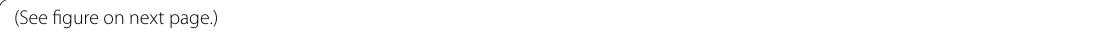
histopathology(See figure on next Fig. 7 Examples of false‑positive and false‑negative diagnosis of Meckel diverticulum. a A 4‑year‑old boy with false‑positive diagnosis of Meckel diverticulum which later proved to be Henoch–Schonlein purpura. Transverse ultrasound at the level of the gall bladder showed a lesion mimicking the pseudogestational sac sign. Nuclear study done after 4 days was negative. Clinical and follow‑up assessment confirmed the diagnosis of Henoch–Schonlein purpura. b A 2‑year‑old girl with false‑positive diagnosis of Meckel diverticulum and later diagnosed to be duplication cyst. Nuclear study done on the following day was negative. Retrospective analysis revealed a characteristic “gut signature” formed by the echogenic mucosa (open green arrow) and hypoechoic muscle layer (open red arrow). c , d A false‑negative case of Meckel diverticulum diagnosed as acute appendicitis by ultrasound in a 6‑year‑old boy. Nuclear study performed on the following day showed a focus on increased updated at the right lower quadrant of the abdomen (read arrow). The findings were confirmed on surgery and